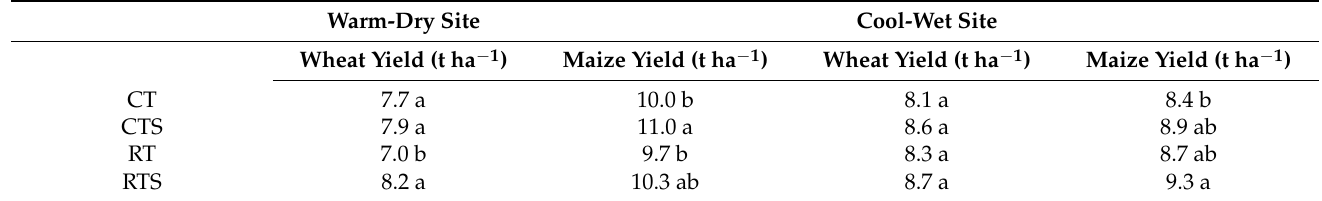
Table 1. Mean yield of wheat and maize under different tillage and straw returning from 2010 to 2019. Warm-Dry